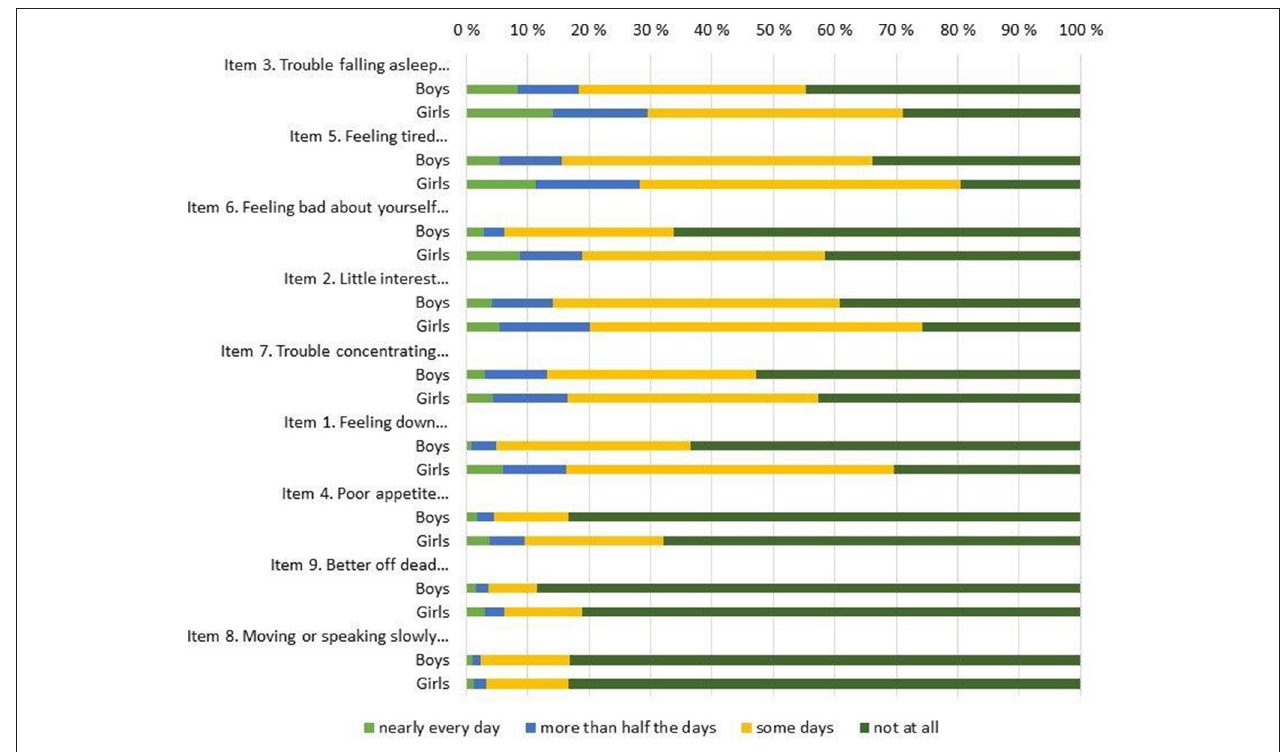
FIGURE 2 | PHQ-9 item response frequency distribution by gender.